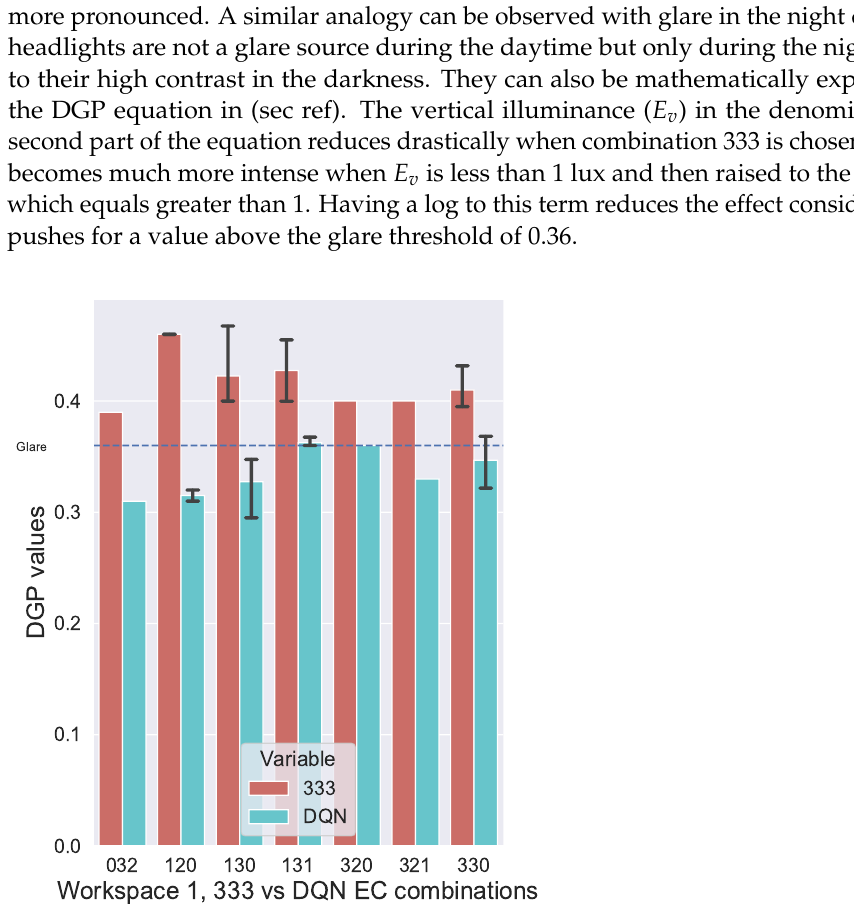
Figure 15. Workspace 1 : Comparison of 333 (dark) combination with DQN-proposed